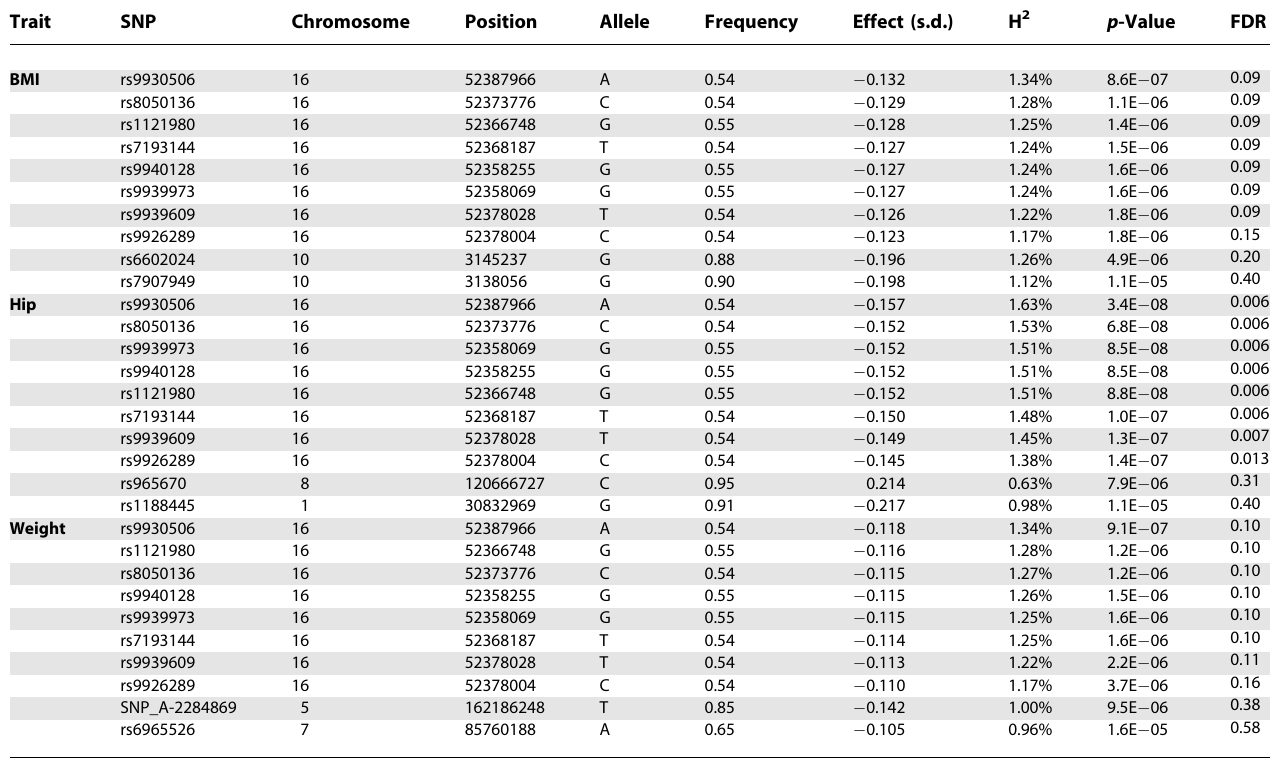
Table 1. Markers Showing Strongest Evidence for Association Trait